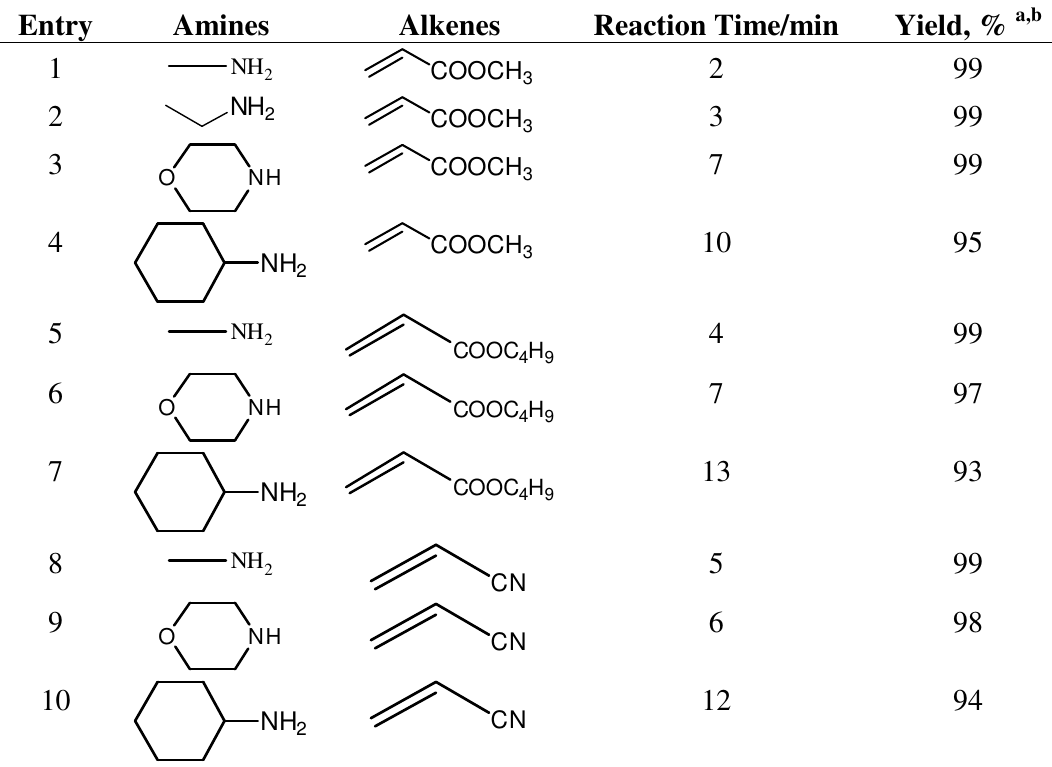
Table 1. The conjugate additions of various amines with